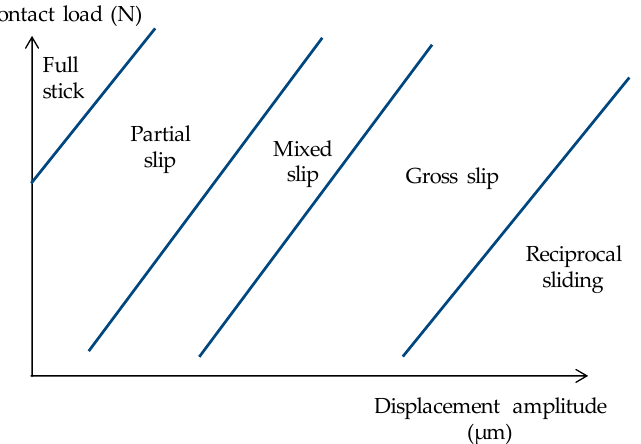
Figure 1. Schematic illustration of a running condition fretting map in terms of contact load and displacement amplitude, redrawn with permission from [2,5].